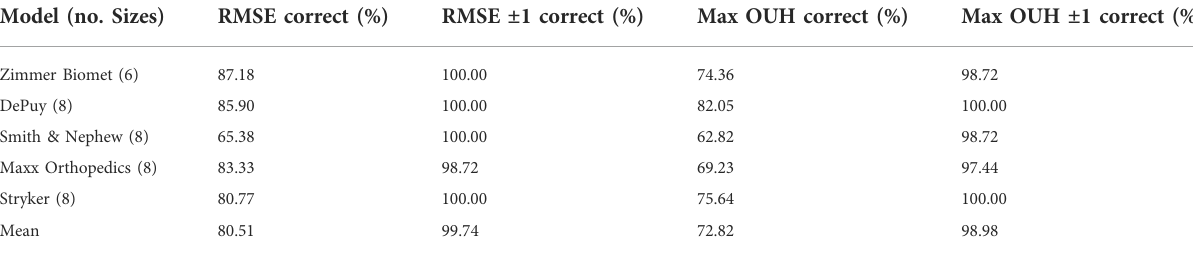
TABLE 5 Tibia plate size prediction accuracies for each manufacturer model sizings. Size prediction accuracy is shown in terms of RMSE and maximum OUH, as well as allowing for ± one model size. Model (no.